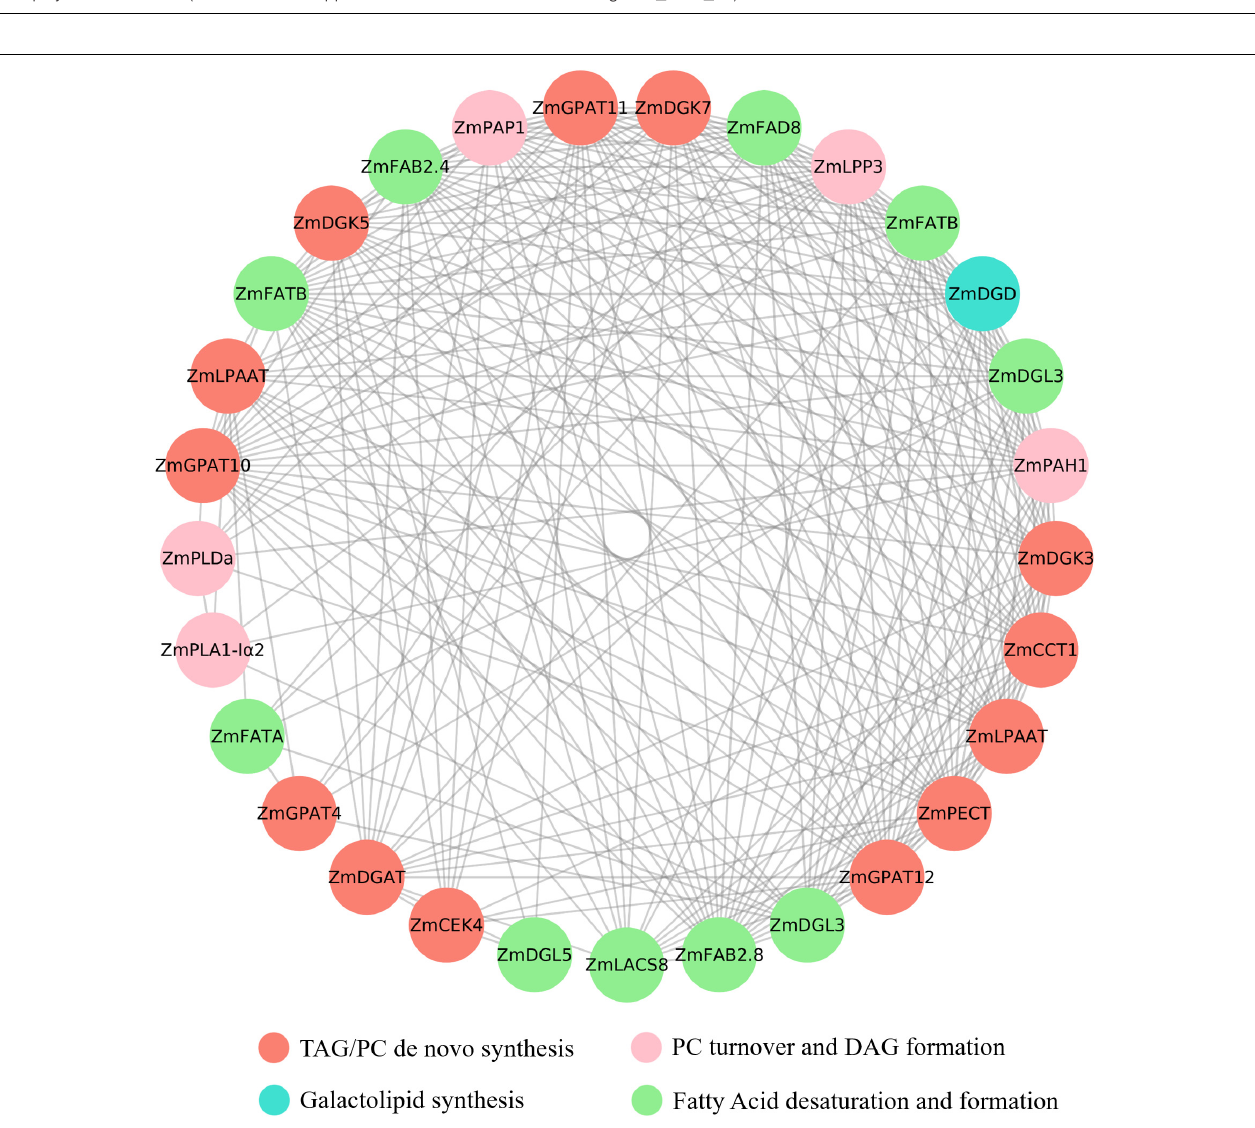
FIGURE 5 | Co-expression of lipid related genes. Different colors represent different genes. The co-expression network was constructed with the reserved gene pairs. The constructing and visualizing of the co-expression network was carried out with the Cytoscape software.